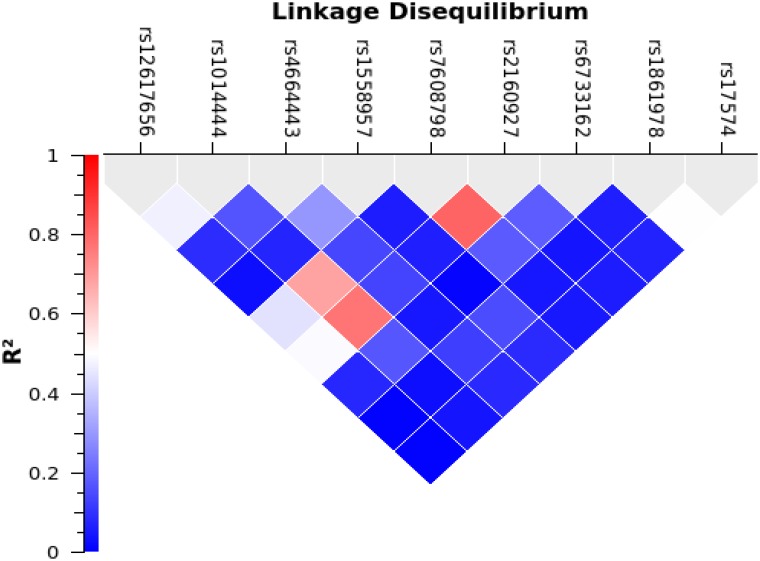
Pairwise linkage disequilibrium among DPP4 SNPs in Malaysian subjects.Values in the upper represent DPP4 SNPs, while values in the left represent the R2 value.